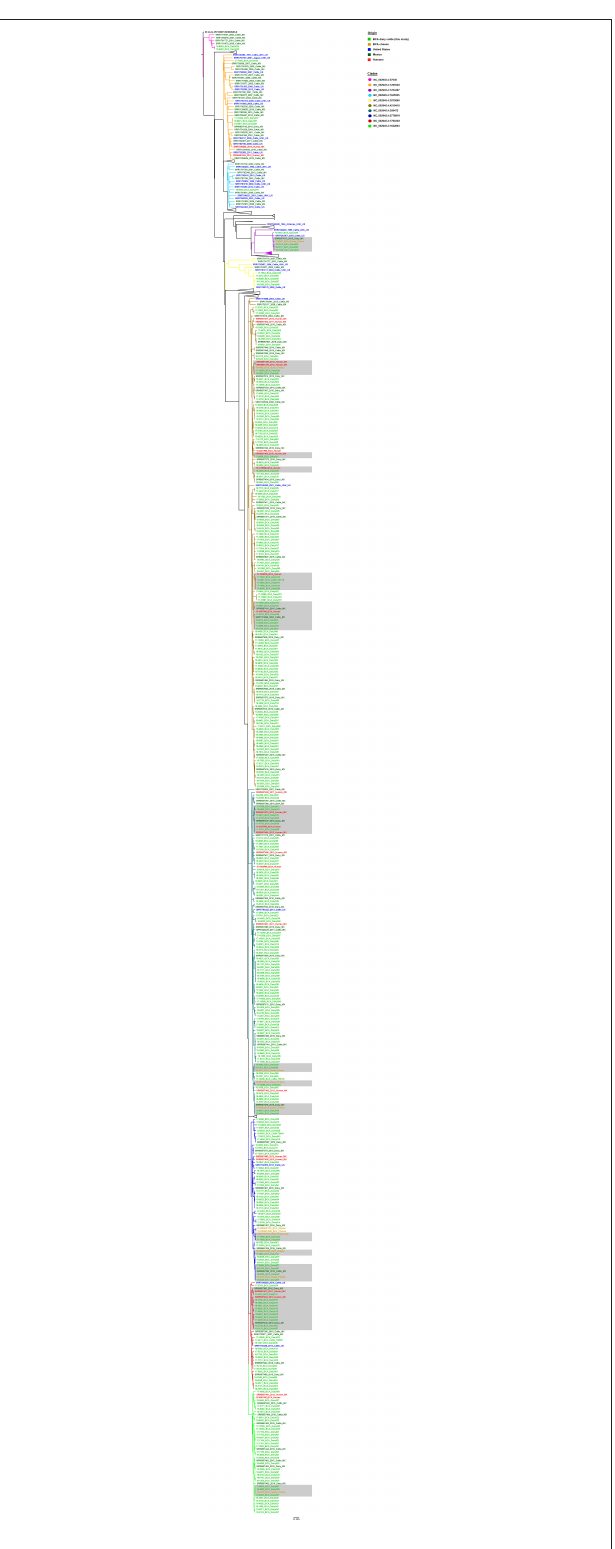
FIGURE 3 | Whole-genome SNP-based phylogeny of 642 M. bovis isolates obtained from cattle, cheese and humans from Baja California, Mexico (BCA)